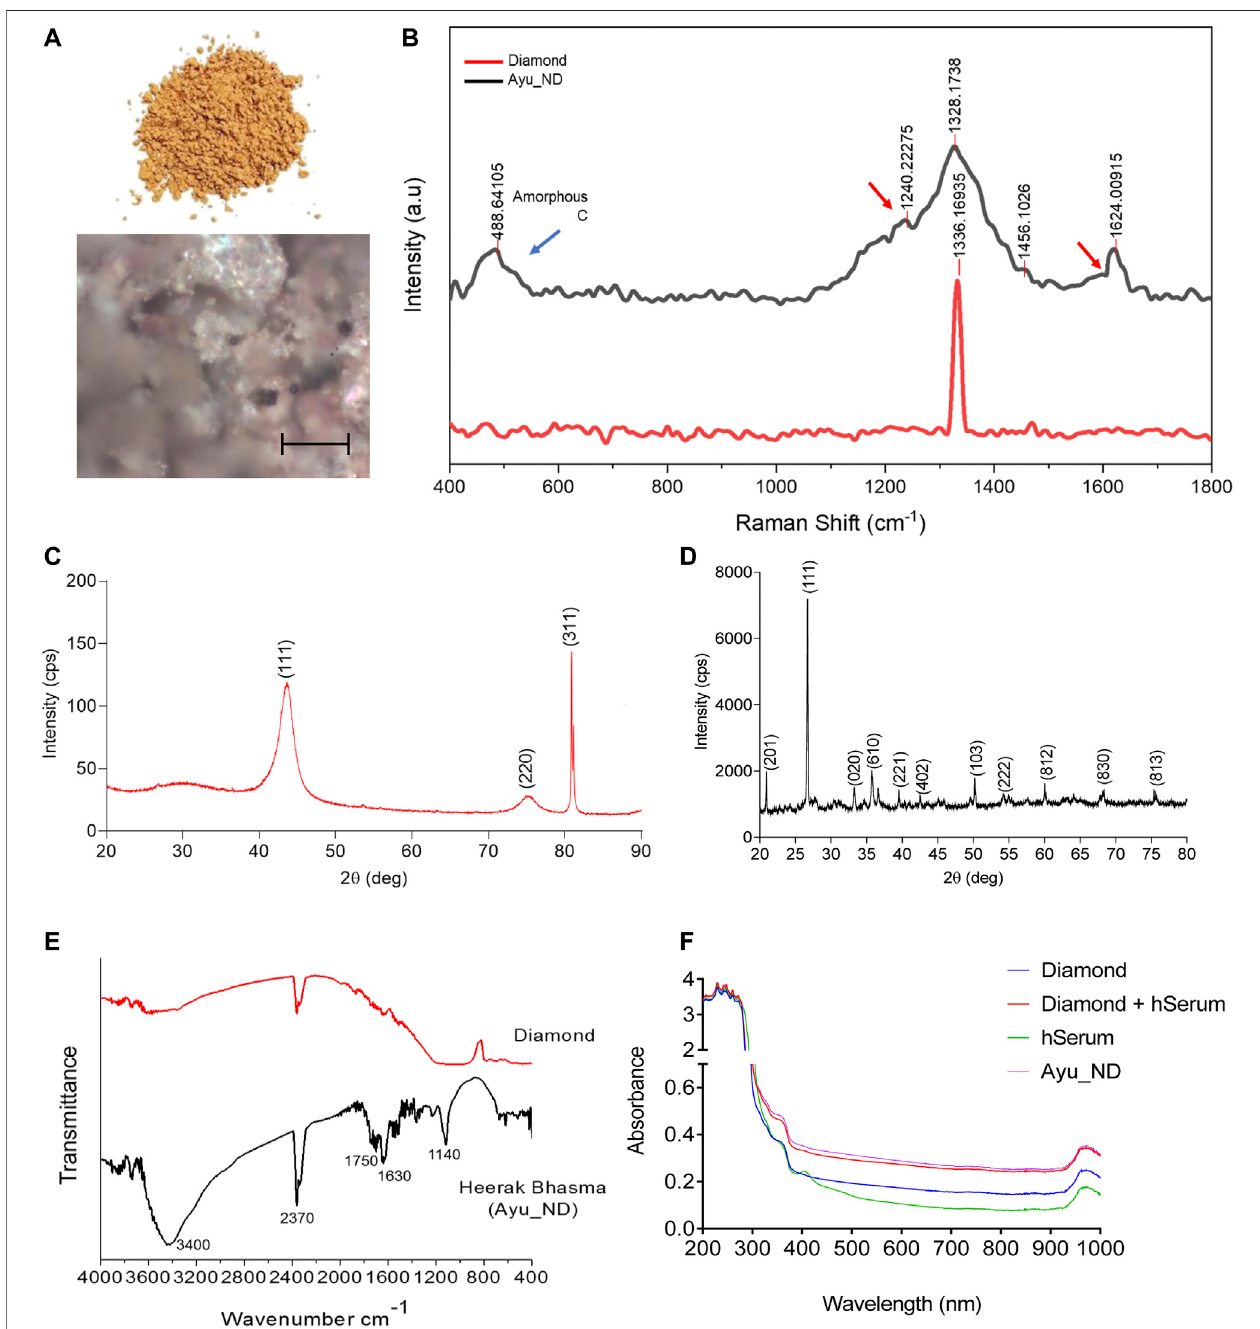
FIGURE2| Spectroscopic analysisofAyu_ND. RepresentativeOpticalimages ofthree similar experiments areshown (A) and Ramanspectraofdiamondpowder only (red) and after the formation of Ayu_ND (black) (B) . X-ray diffraction pattern of the diamond powder only (C) and formed Ayu_ND nanomaterial (D) . FTIR spectra of diamondpowderonly(red)andAyu_ND(black) (E) .UVabsorptionspectraoffreeC_ND,humanserum,humanserumabsorbedC_NDandAyu_ND (F) .Theexperiment was repeated independently three times to con fi rm the results.